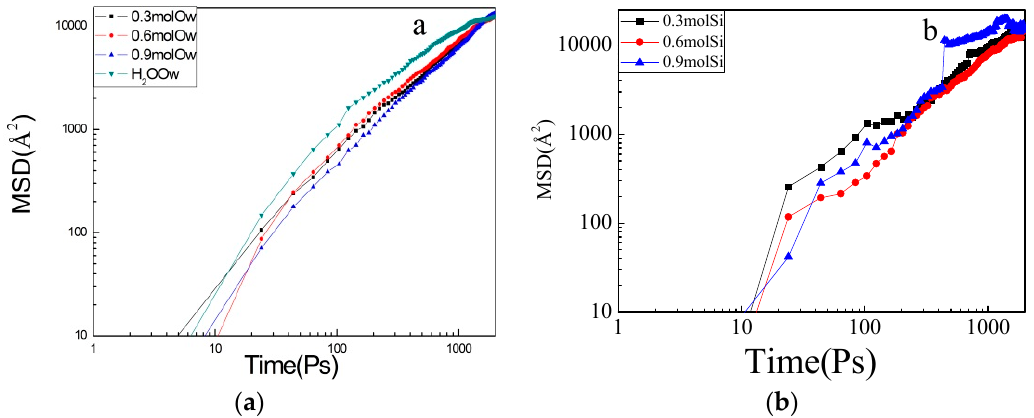
Figure 8. Mean square displacement (MSD) evolution for ( a ) water molecules in different concentration models, and ( b ) siloxane molecules at in different concentrations. Table 1. Number of adsorbed water molecules and ions* on the calcium silicate hydrate (C–S–H) channel at 2000 ps.